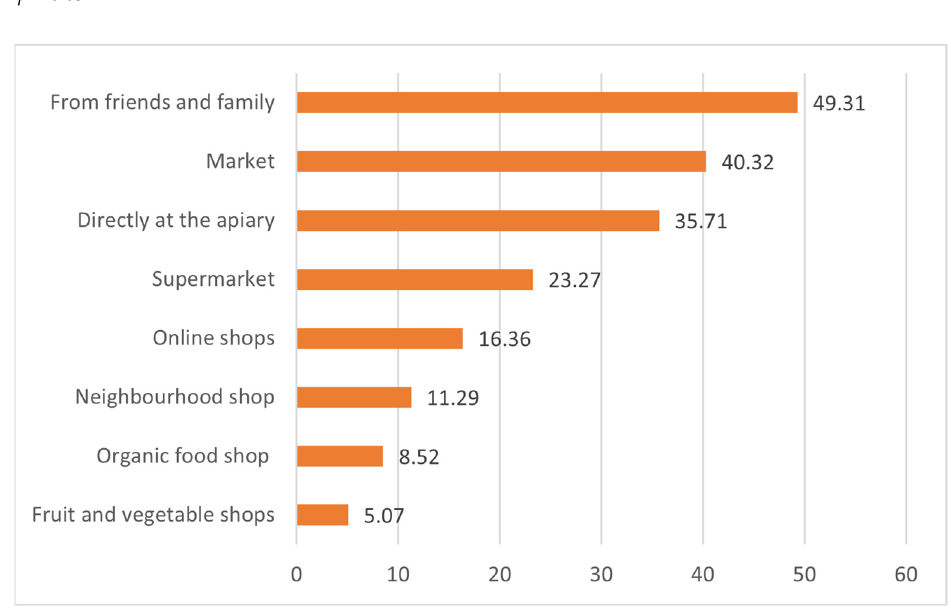
Figure 6. Ways of obtaining honey ( n = 434, data in %).